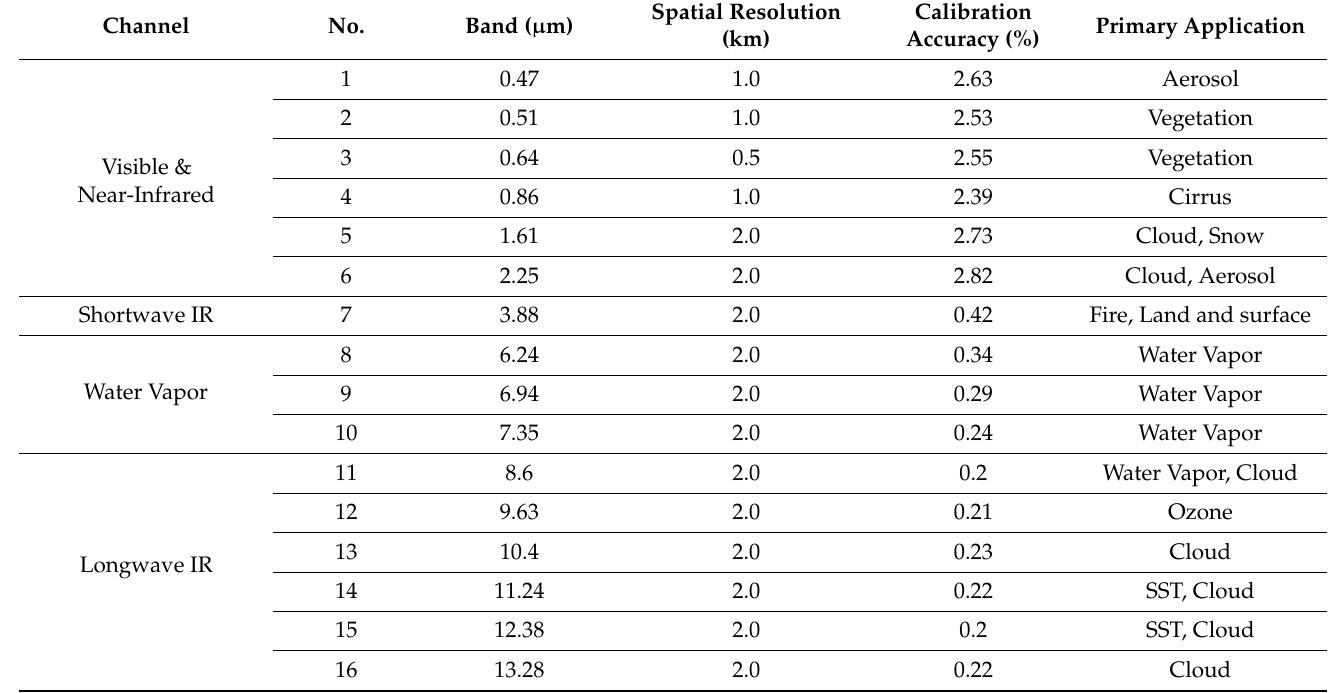
Table 1. Himawari-8